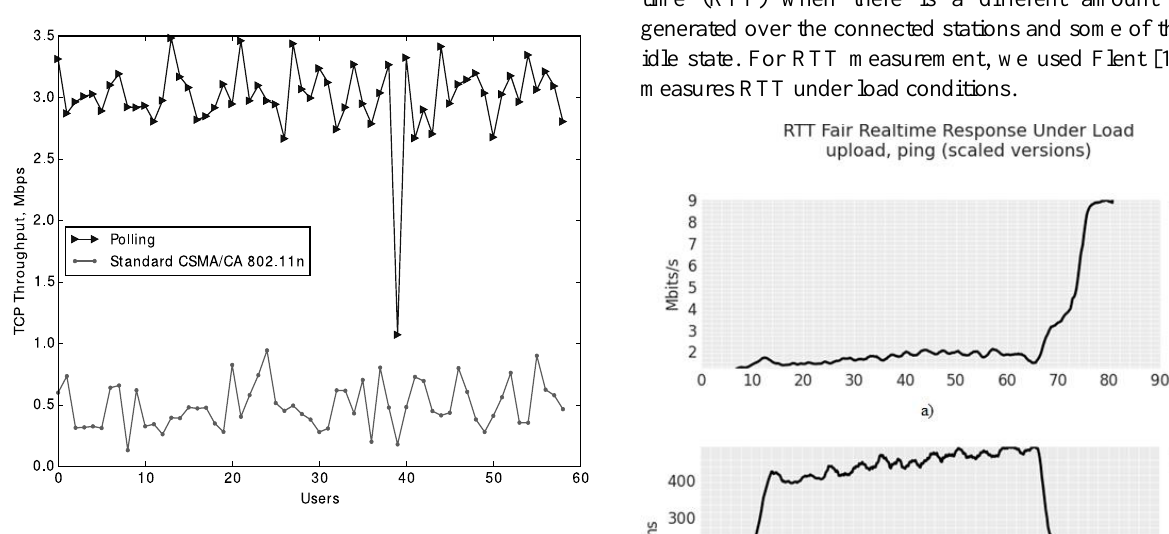
Fig. 3. Throughput under different protocols with 60 clients. Average RSSI − 5 dBm.